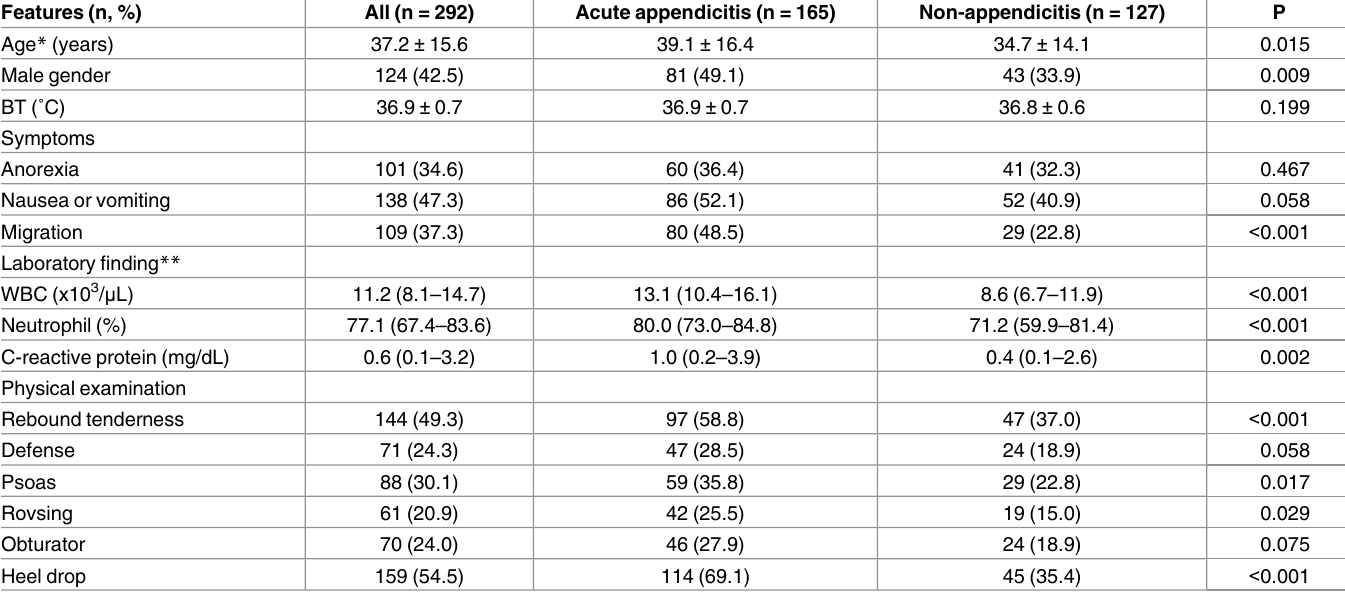
Table 1. Demographic and clinical data for the study population.